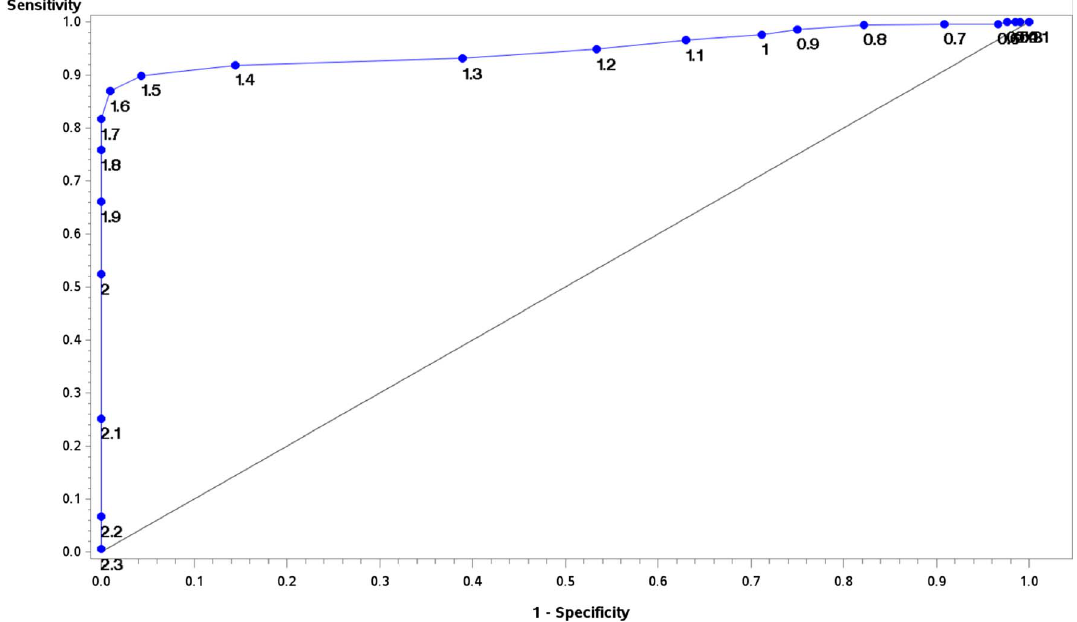
Figure 3. ROC curve for determination of the optimal LSV cut-off. Logistic regression model based on identi fi cation prediction using the fi nal version of the MALDI-TOF cercariae database compared to molecular identi fi